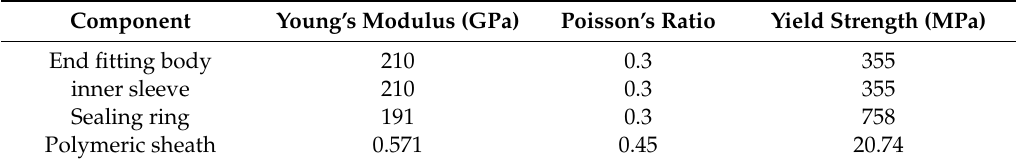
Table 1. Materials and properties for each part of the model.